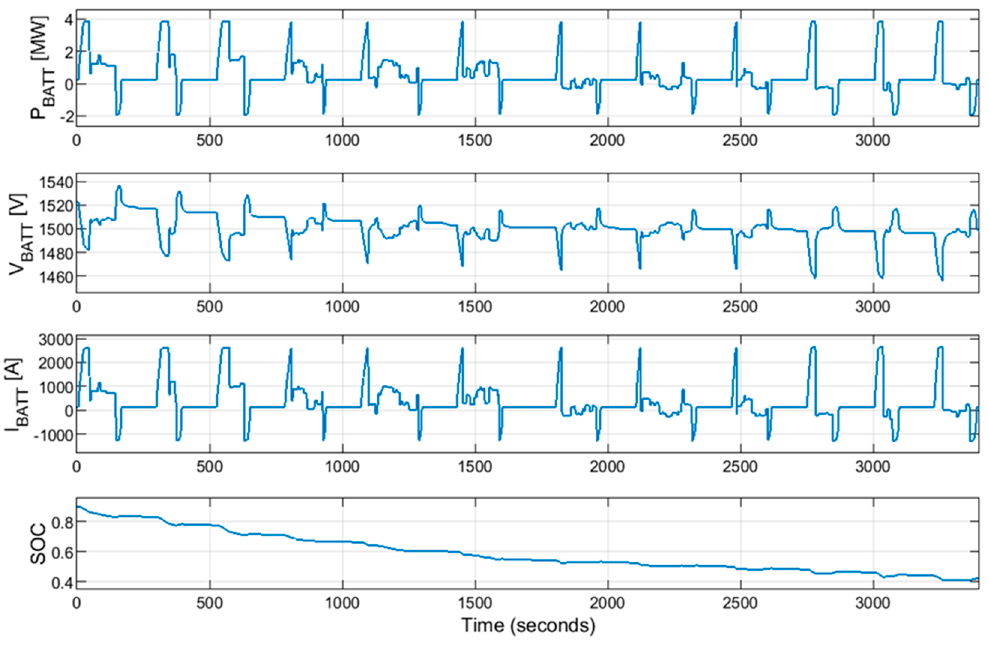
Figure 17. High autonomy ESS parameters-High-power lithium ion cells.